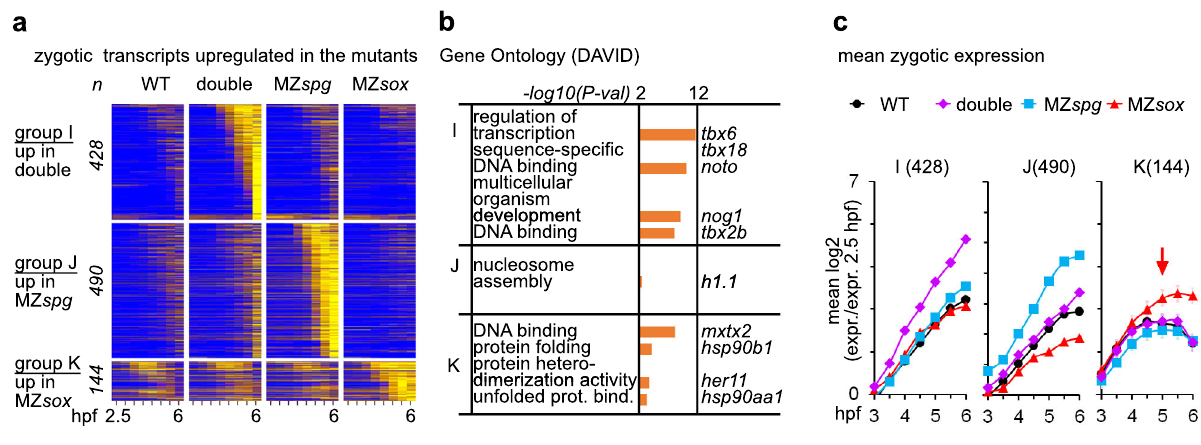
Fig. 4 Simultaneous loss of Pou5f3 and Sox19b leads to increase in dorsal gene expression and premature activation of differentiation factors. a Heatmap for 1062 zygotic transcripts, upregulated in the mutants compared to the wild type. The upregulated transcripts were grouped as indicated in the left (groups I, J, K), and sorted by ascending switch time and switch p -value in the respective mutant. b The groups I, J, K were tested for enrichment in Gene Ontology terms using DAVID. Top four categories per group/example genes are shown. Note that the group I upregulated in MZ sox19bspg is enriched for the regulators of transcription and for developmental genes. c Mean zygotic transcription pro fi les for the groups which are upregulated in the mutants compared to the wild type (I, J, K), relative to 2.5 hpf. Note the early upregulation of the transcripts over the WT in MZ sox19bspg (group I) and MZ spg (group J), but not in MZ sox19b (K), where the transcripts are mostly upregulated at 5 hpf (red arrow). MZ sox = MZ sox19b . n (wt) = 4, n (MZ spg ) = 2, n (MZ sox19b ) = 2, n (double) = 2, where n is a number biologically independent experiments. Data are presented as mean values ± SEM. Source data for a , c are provided as a Source Data fi le. Source data for a , b are provided as Dataset